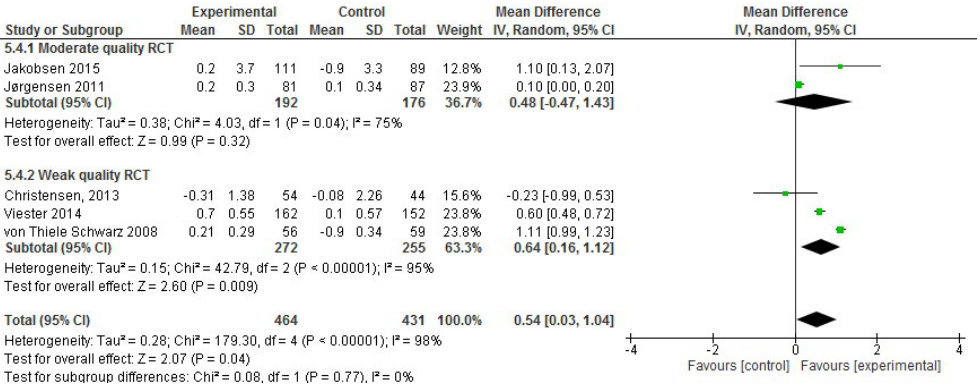
Figure 8. Forest plot of the effectiveness of workplace interventions for improving employees’ work ability according to the quality of the studies.